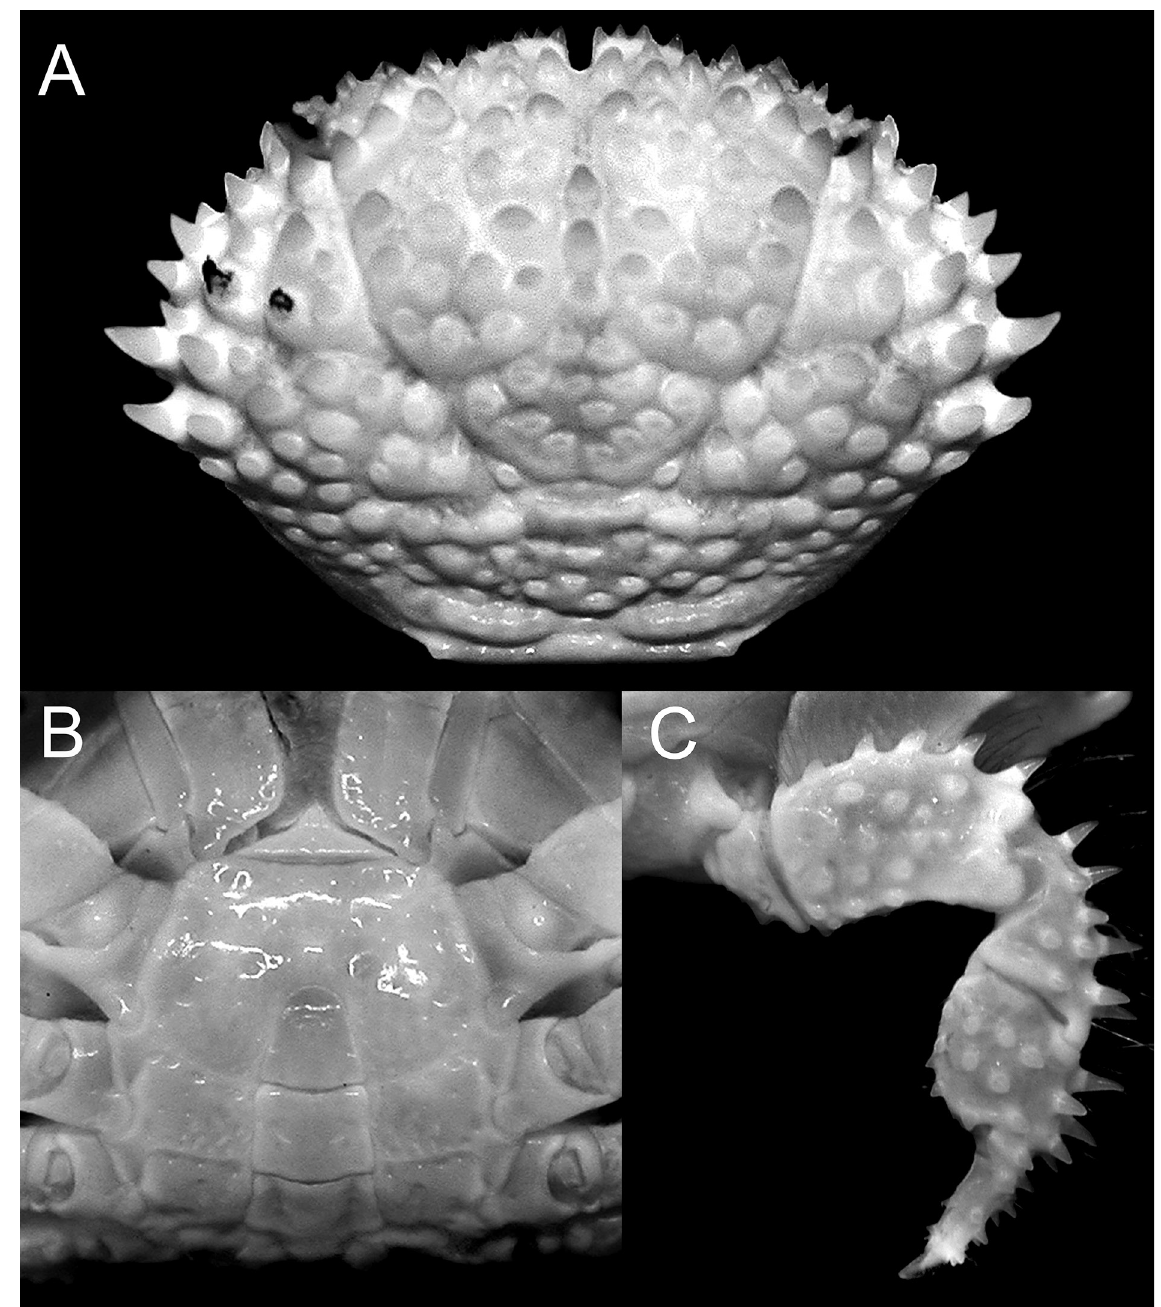
Fig. 9. Actaea spinosissima Borradaile, 1902, ♂, 8.9 × 6.6 mm (ZRC), Chagos Islands A . Dorsal view of carapace. B . Thoracic sternum showing vulvae. C . Right fourth ambulatory